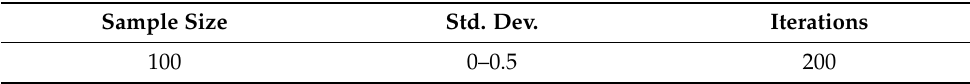
Table 4. Model parameters for the Example 3.